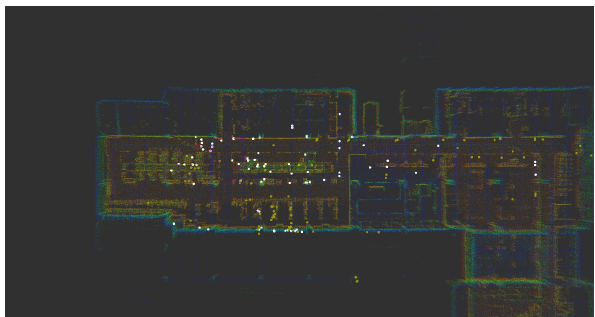
Figure 5. Registration Result of 3D Lidar Observation